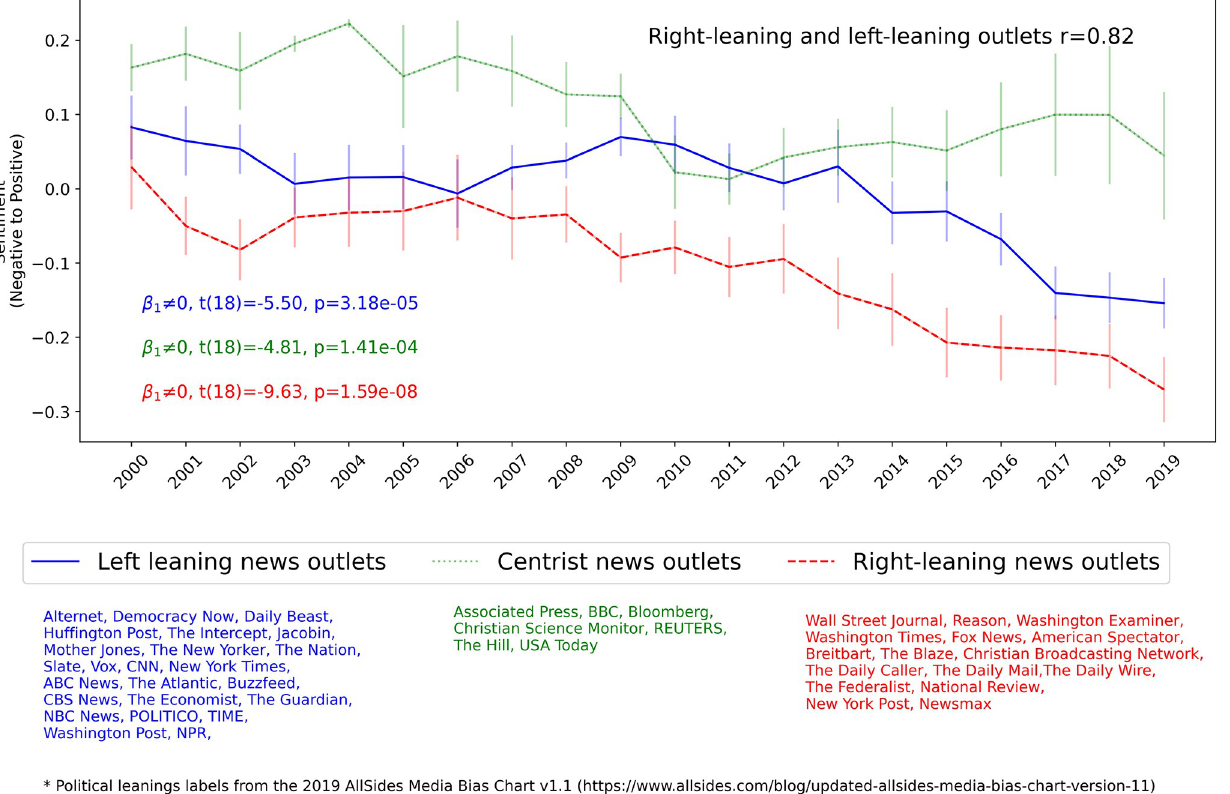
Fig 2. Average yearly sentiment of headlines grouped by the ideological leanings of news outlets using human ratings of outlets political bias from the 2019 AllSides Media Bias Chart v1.1 [24]. The figure displays the standard error bars of the average yearly sentiment for outlets within each color-coded political orientation category. For each ideological grouping, statistical tests for the null hypothesis of zero slope are shown on the bottom left of the plot.